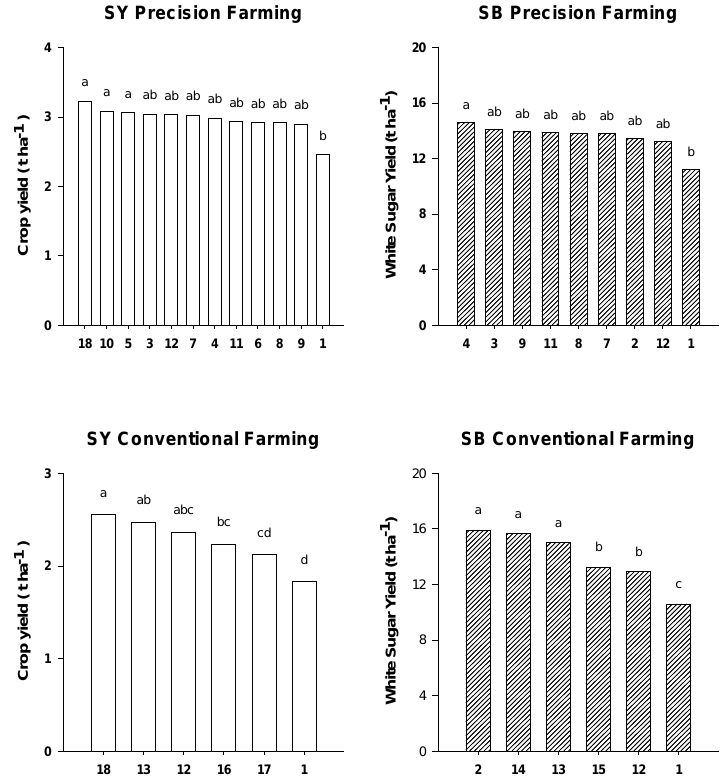
Figure 3. Yield of crop in t ha −1 in the sugar beet (SB) and soybean (SY) treatment at Ihinger Hof, Gützingen, Heidfeldhof, Renningen, Kleinhohenheim in the year 2013 and 2014 and March-Buchheim in 2013. Precision farming experiments were conducted at Ihinger Hof in SB and SY in 2014. Data of the conventional farming experiments of different locations were averaged. Bars represent mean values, within each experiment and measurement date, significant differences ( p ≤ 0.05) are topped by different